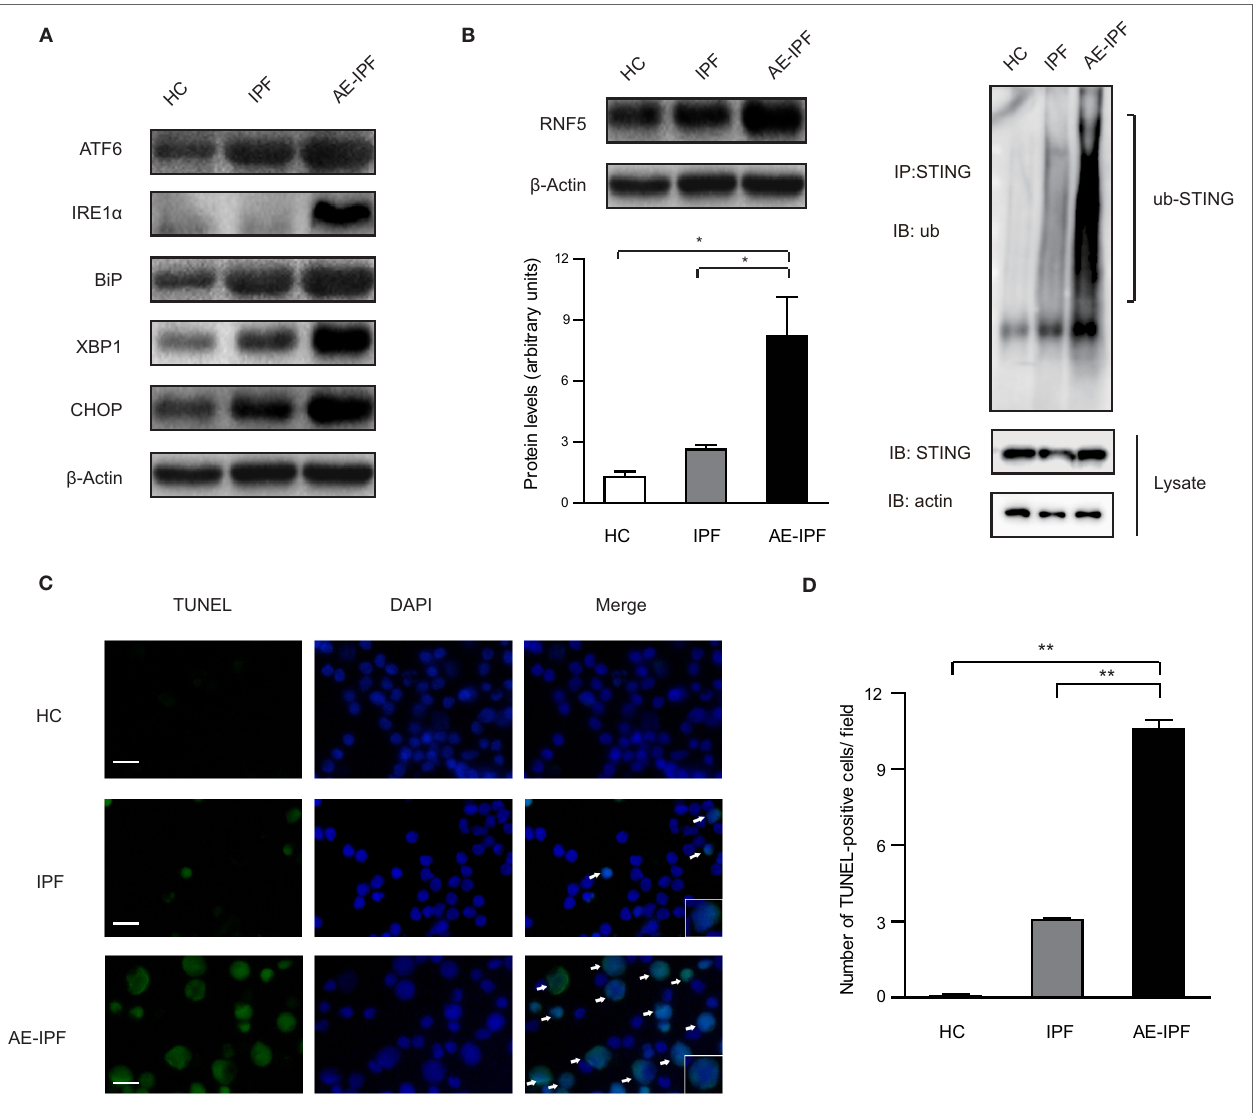
FigUre 3 | Endoplasmic reticulum (ER) stress and unfolded protein response were activated in the primary peripheral blood mononuclear cells (PBMCs) of patients with acute exacerbation of idiopathic pulmonary fibrosis (AE-IPF). (a) Representative Western blot image for the expression of the ER stress markers, activating transcription factor 6 (ATF6), inositol-requiring enzyme 1 α (IRE1 α ), binding immunoglobulin protein (BiP), X-box protein 1 (XBP1), and C/EBP homologous protein (CHOP) in PBMCs from the three groups. β -actin was the loading control. (B) Western blot analysis of RNF5 protein expression in the primary PBMCs of the three groups ( n = 12). The intensity of the band was normalized to β -actin (left). The ubiquitination of endogenous stimulator of interferon genes (STING) in PBMCs from the three groups (right). (c) Representative immunofluorescence staining of TUNEL assay. Green signals represent TUNEL positive nucleus and blue signals represent nuclei. White arrows are pointing to apoptotic cells. Magnification: × 400; scale bars represent 20 µm. (D) Quantification of the TUNEL assay ( n = 6). Data are presented as means ± SEM, * p < 0.05; ** p <